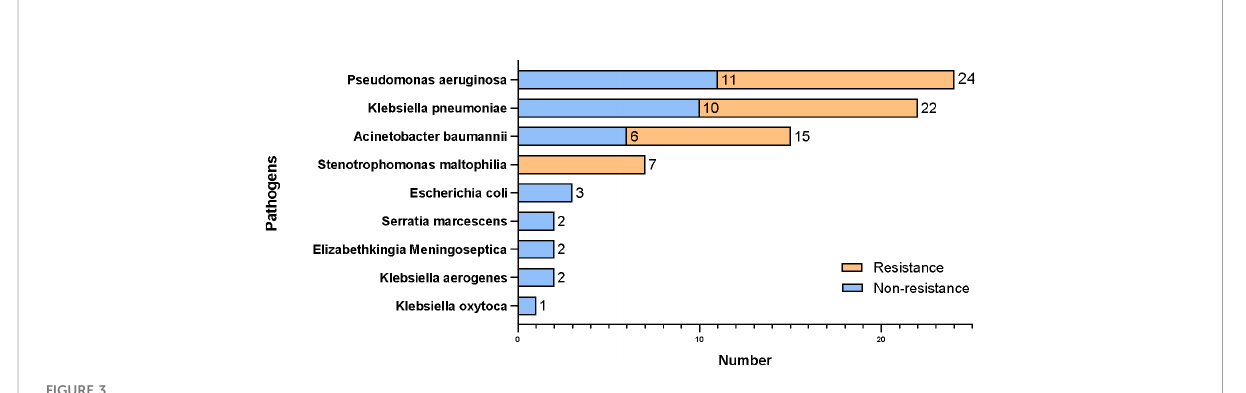
FIGURE 3 Results of microorganism culture and carbapenem resistance pro fi